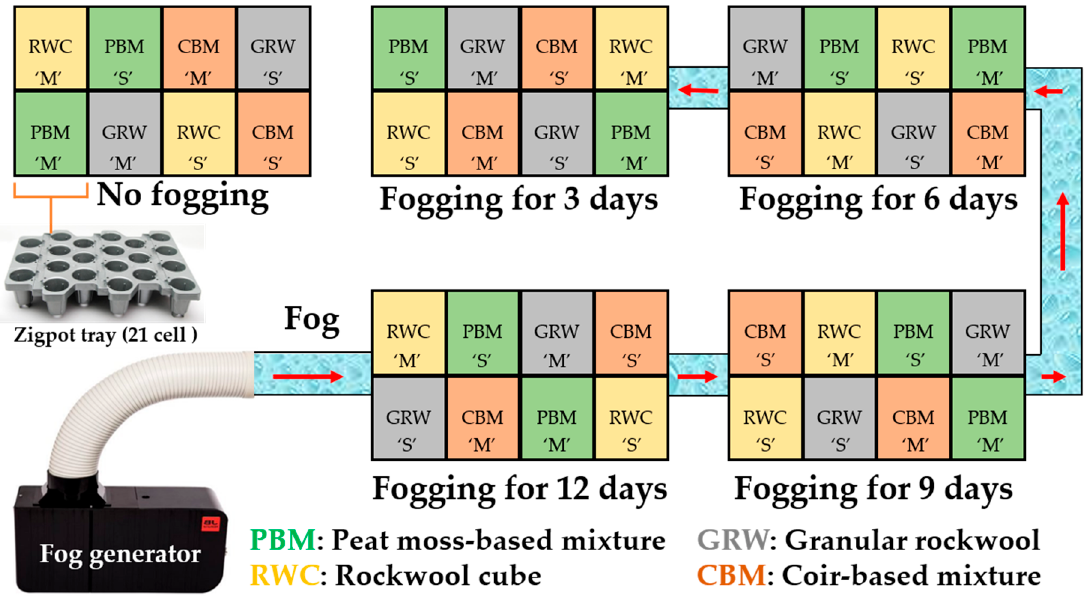
Figure 3. Experimental design to study the effects of the growth medium and fogging duration on the rooting and early growth of daughter plants of strawberry ‘Maehyang’ (‘M’) and ‘Seolhyang’ (‘S’).